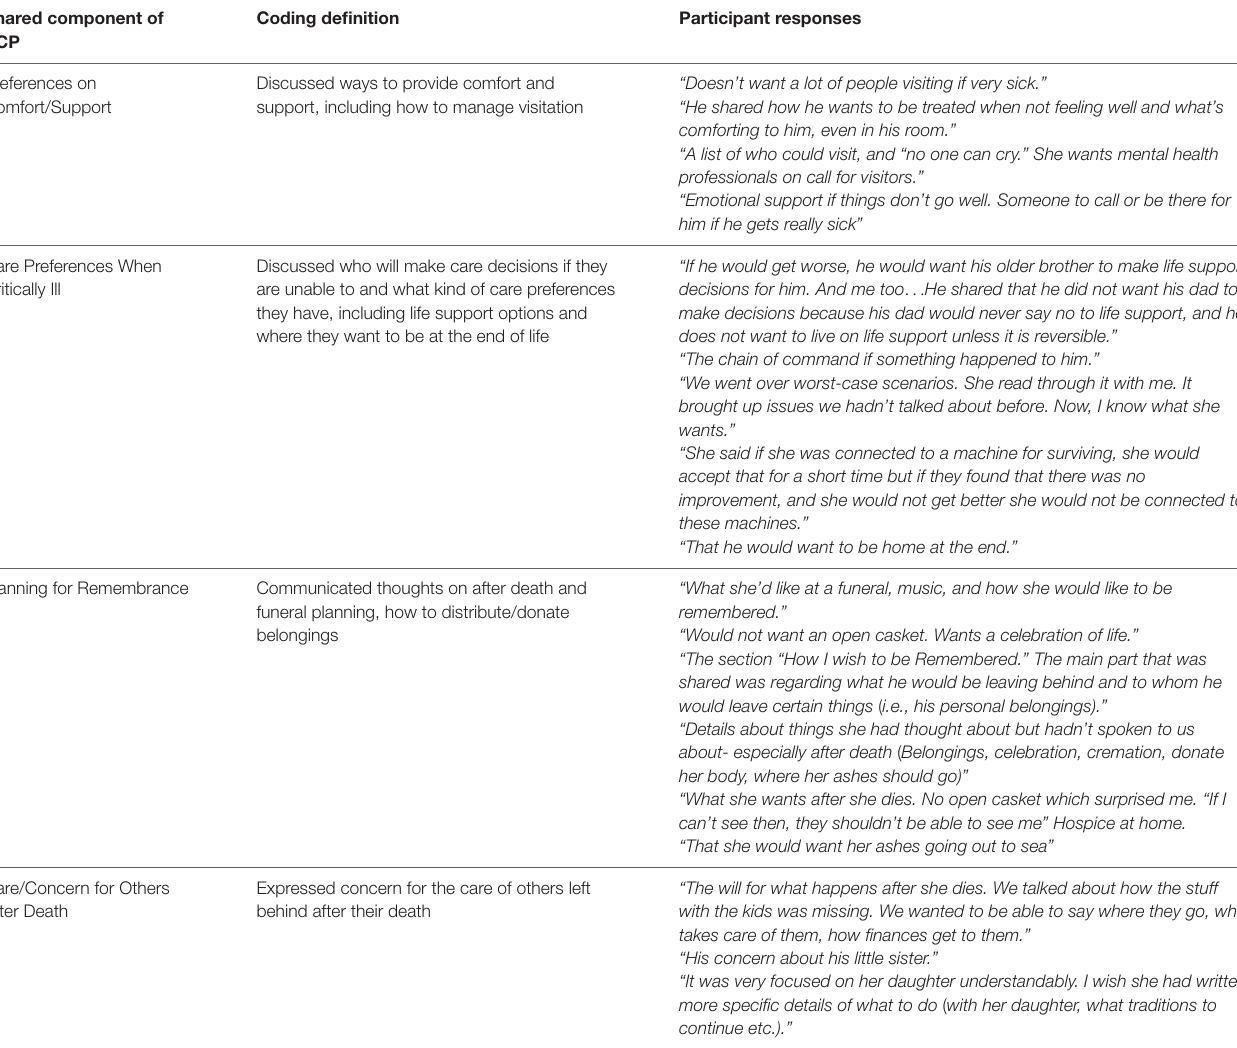
TABLE 1 | Part of ACP shared with participant post-VMC completion.